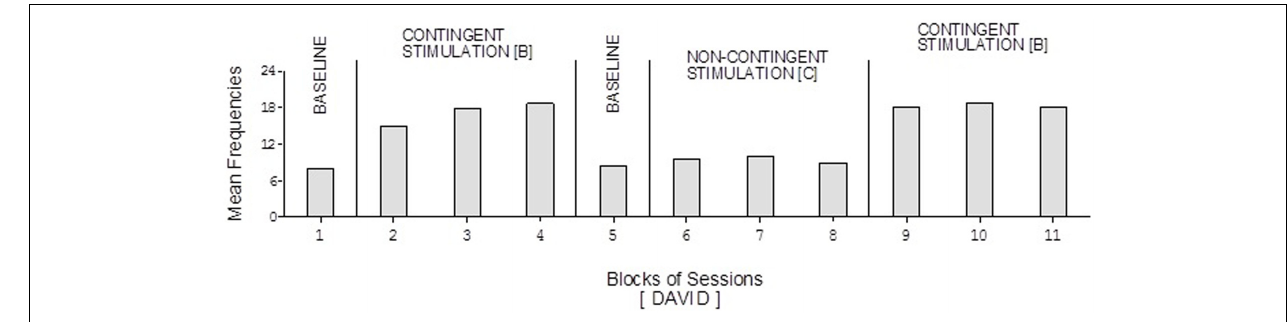
FIGURE 4 | David’s data plotted as in Figure 2.